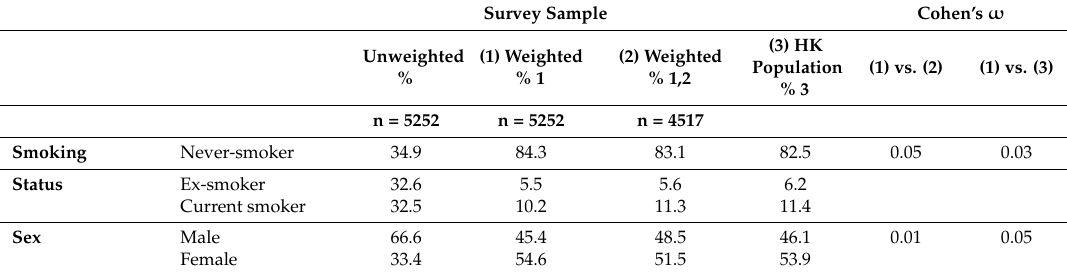
Table 1. Unweighted and weighted figures of baseline socio-demographic characteristics ( n =